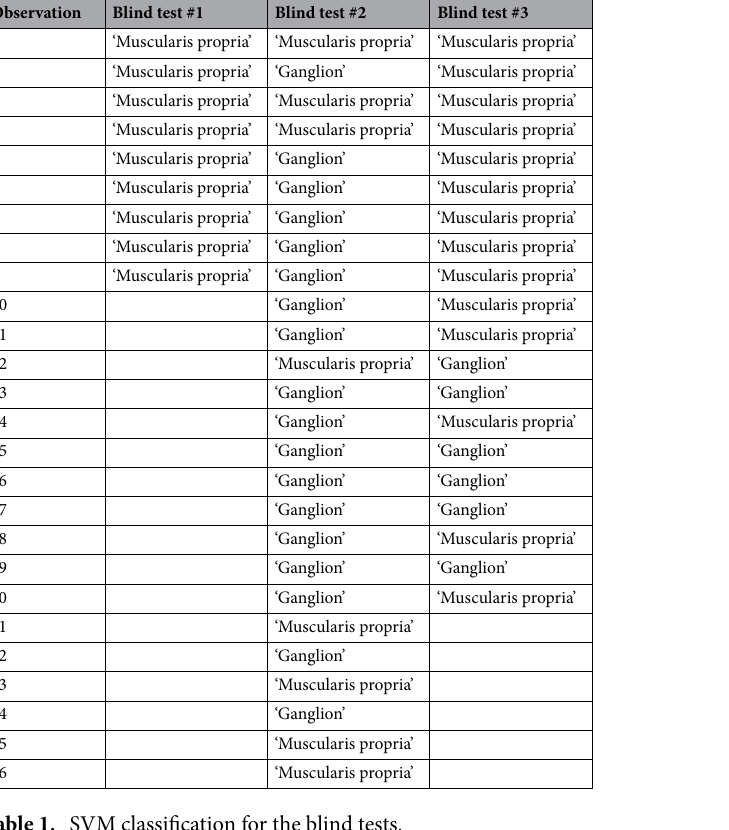
Table 1. SVM classification for the blind